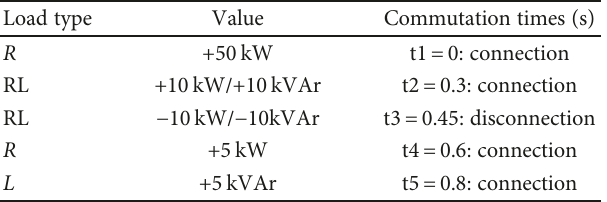
Table 3: Loads used in the system and times that they entered the circuit.